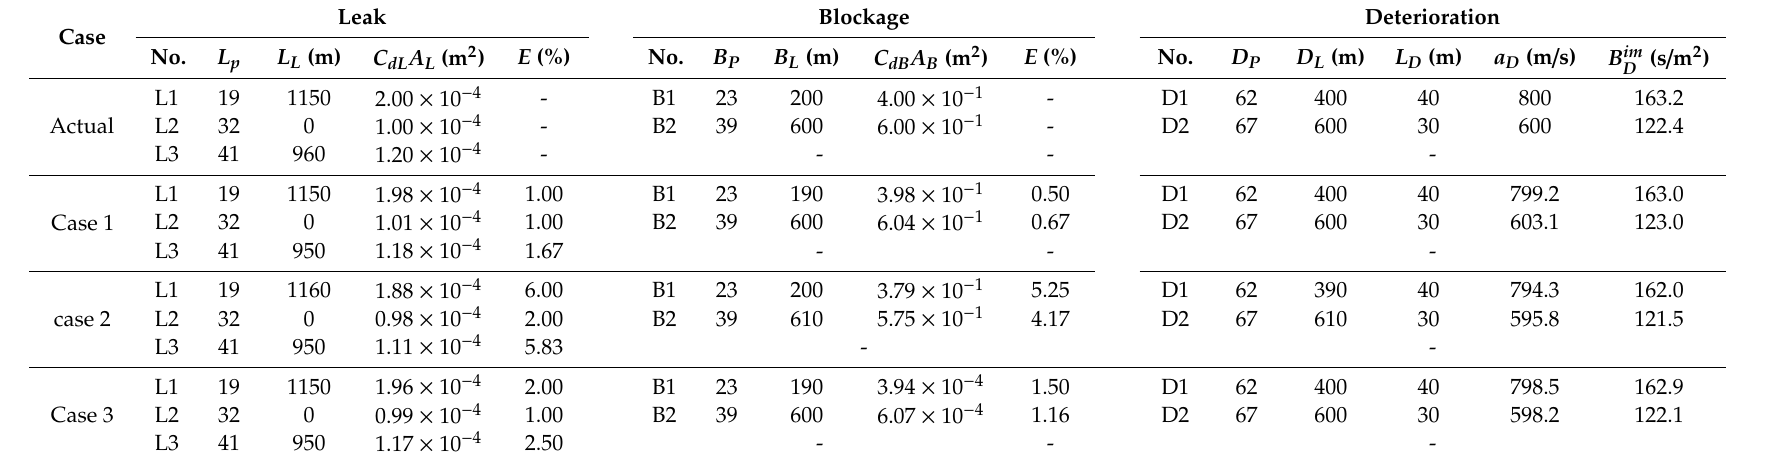
Table 8. The optimal fault information of pipe network B predicted by PEOS for three cases.